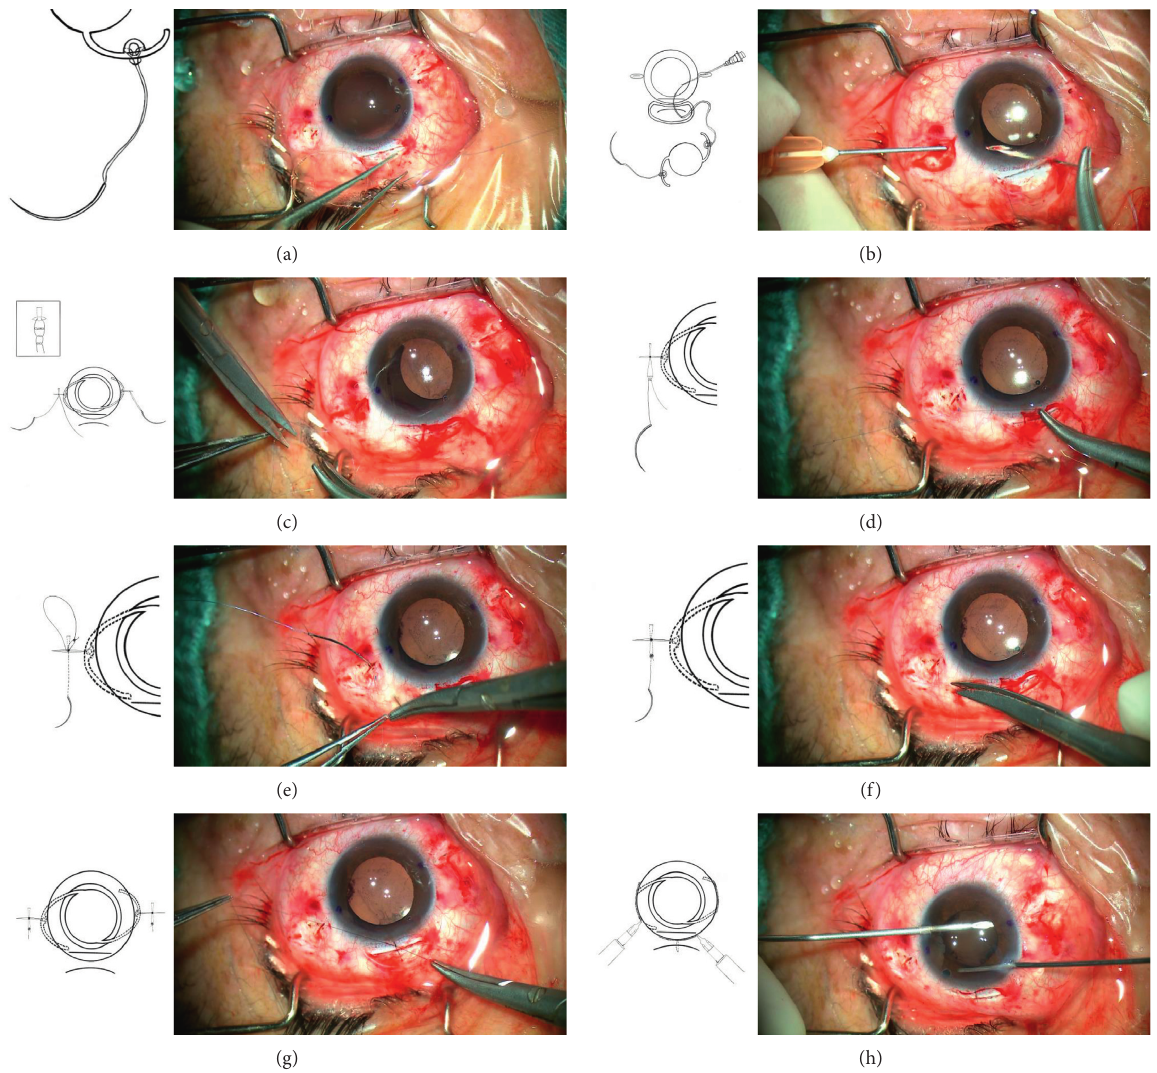
Figure 1: The process of transscleral-sutured IOL fixation. (a) Cow-hitch knots are created with the method that the long curved needle passes through the eyelet of one haptic of the IOL. (b) The curved needle was introduced through the corneal incision, docked into a 23-G needle introduced from the 2 o’clock and 8 o’clock scleral incision, and pulled out. (c) The first ball-shaped knot was created in 3-2-1 fashion. (d) The second ball-shaped knot was created in 3-2-2 fashion and tied about 3mm away from the first knot. (e) The long needle with thread entered the other scleral lamina from the incision and sneaked 4-5 mm between the scleral layers. (f) The second thread knot was buried in the deep sclera. (g) The same procedures were performed for the opposite side and IOL centration adjusted. (h) The peripheral iris was excised at 1 o’clock with 23-gauge vitreoretinal